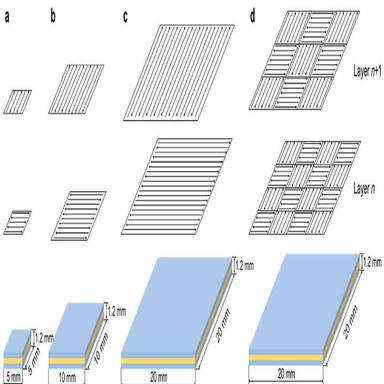
Building strategies used for printing the SS304-IN718-SS304 MMS with different geometric sizes by (a–c) 90◦ rotation scanning strategy and (d) island scan strategy.